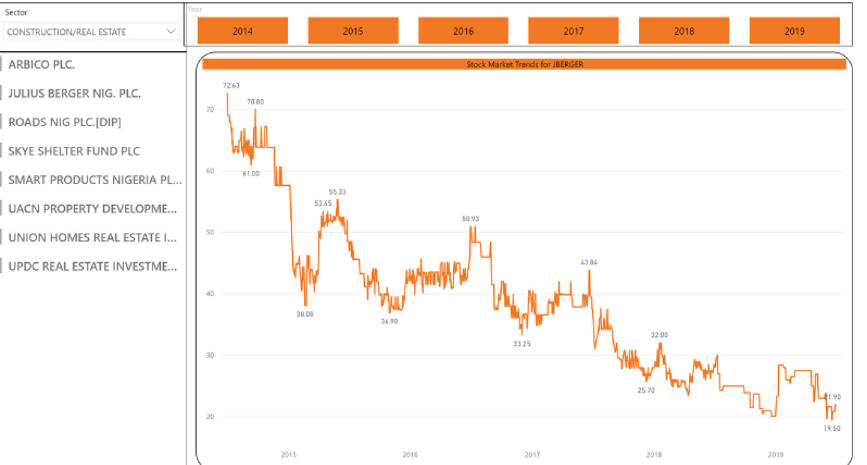
Figure A2. Real estate sector